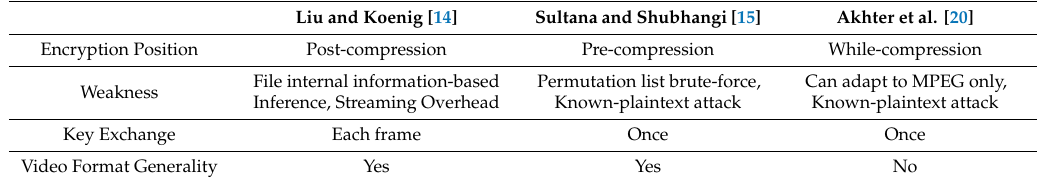
Table 1. Permutation-based video encryption